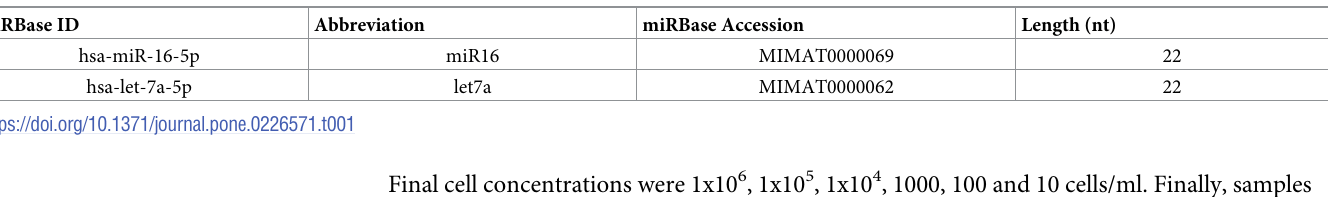
Table 1 and Table 2 list the miRNA and snoRNA species used in this study. For brevity, abbre-